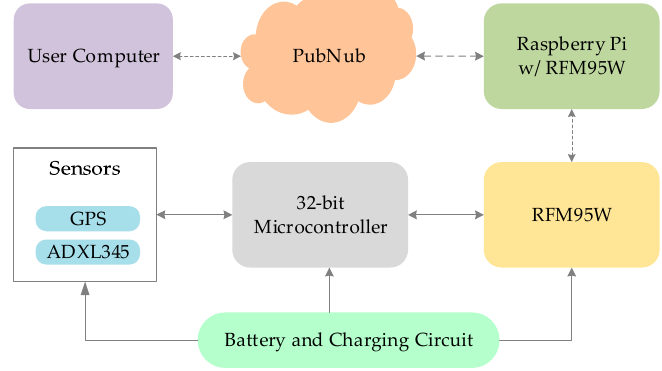
Figure 10. System Architecture for fall detection. Table 3. Current consumption in fall detection system.